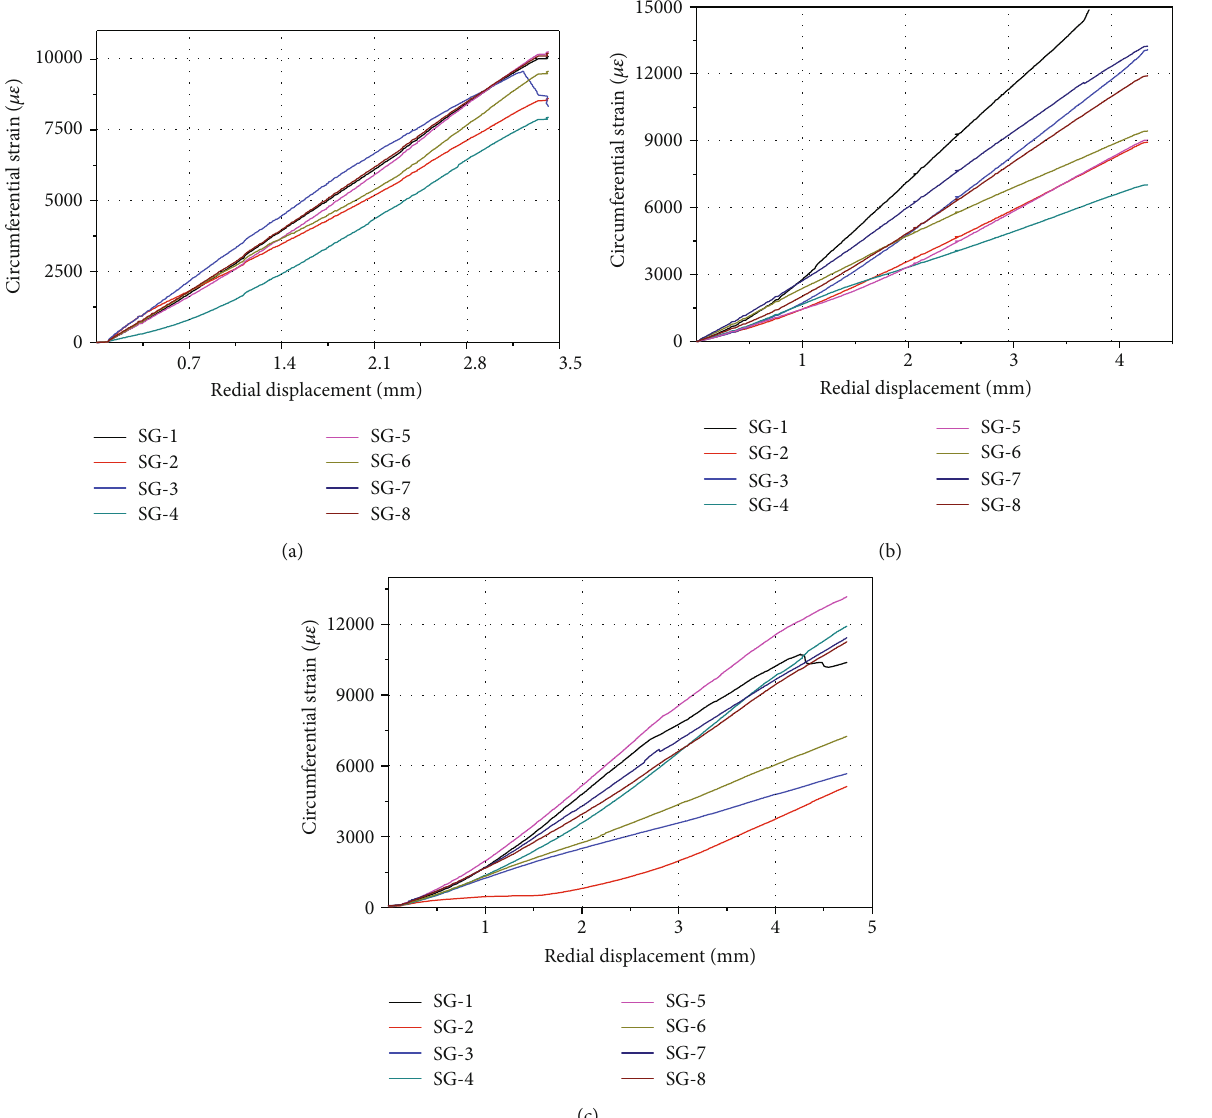
Figure 18: The circumferential strain-radial displacement curve of the test group with 3-layer prepreg wrap: (a) G-3-3 curve, (b) G-3-R-3 curve, and (c) G-3-2R-1 curve.